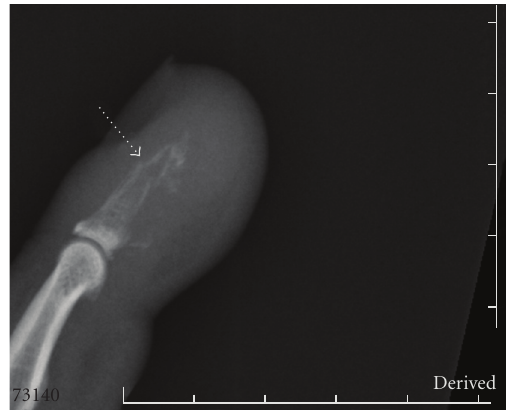
Figure 2: A pathologic fracture of the distal